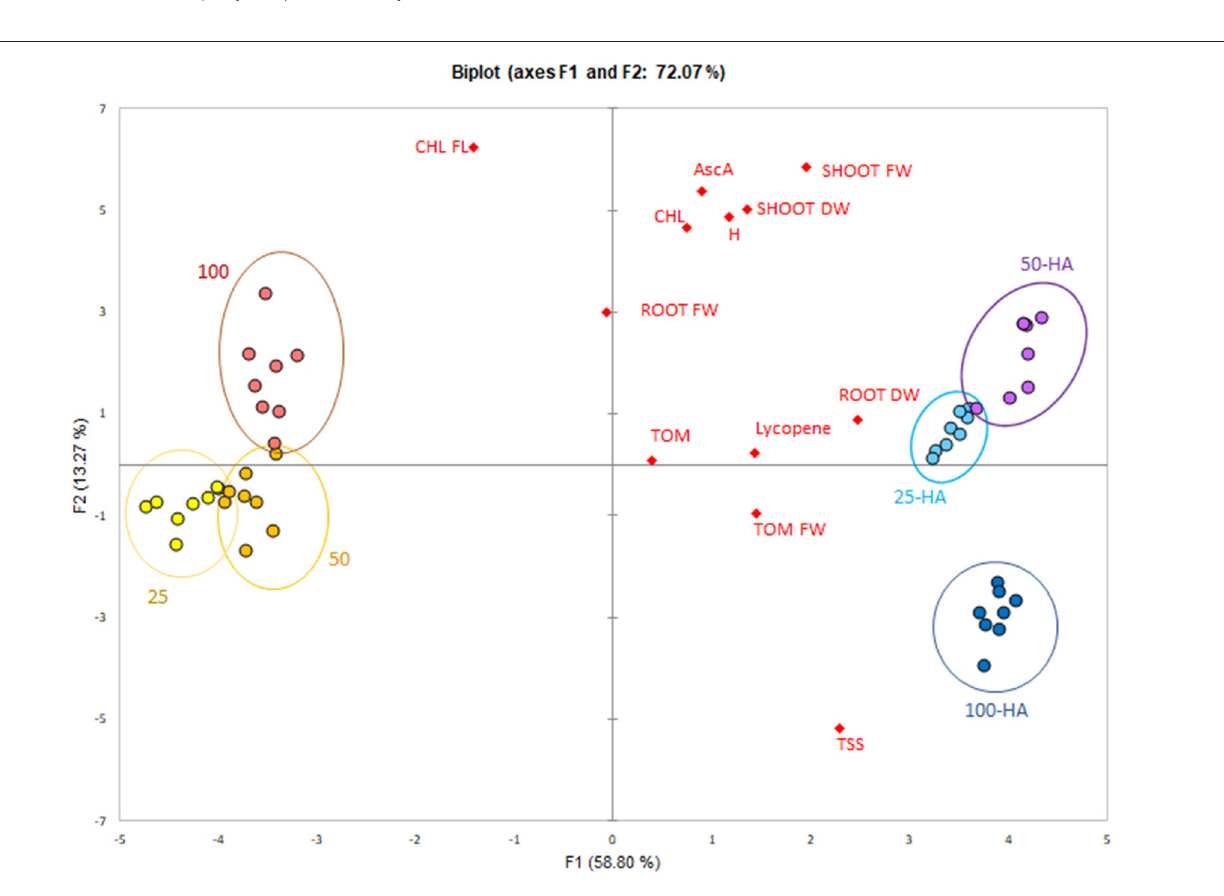
FIGURE 7 | PCA score-plot of plant bioassay. Measured parameters correlation with the application of humic acids at different nutritional